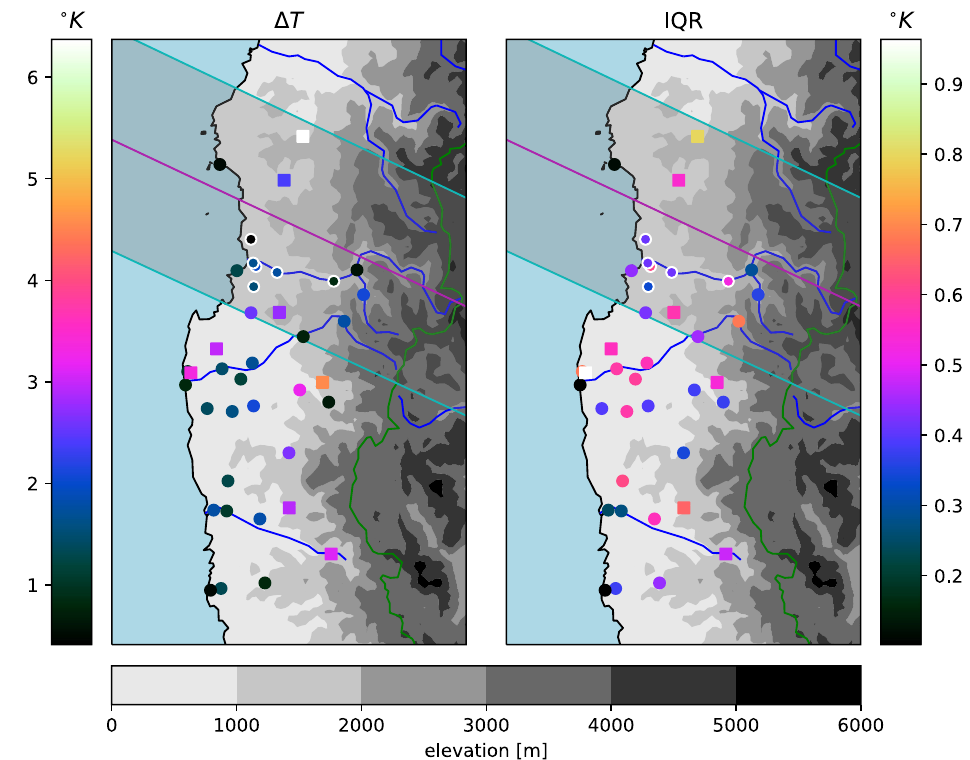
Figure 4. Estimated maximum 2m air temperature depressions as in Fig. 3 (symbols as described there), but for estimates based on the automatic relevance determination (ARD) regression. IQR here is 0.67 times the standard deviation of the predictive